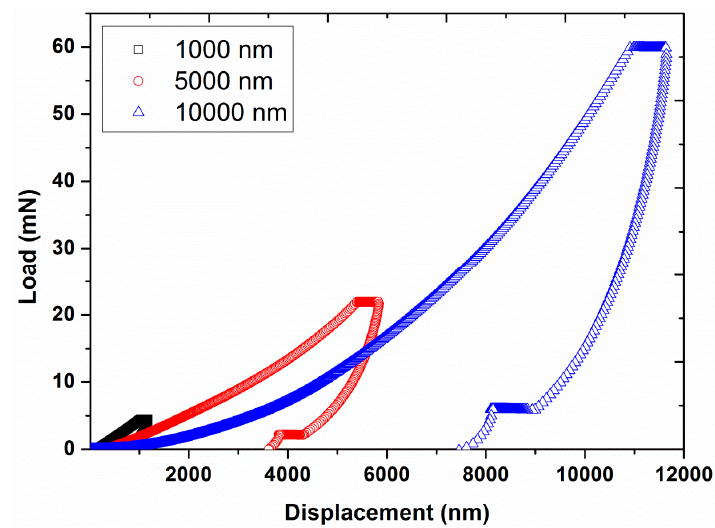
Figure 7. Indentation load as a function of displacement for the three different contact depths (1000, 5000, and 10000 nm) at a vibration amplitude of 2 nm and strain rate of 0.05 s − 1 .